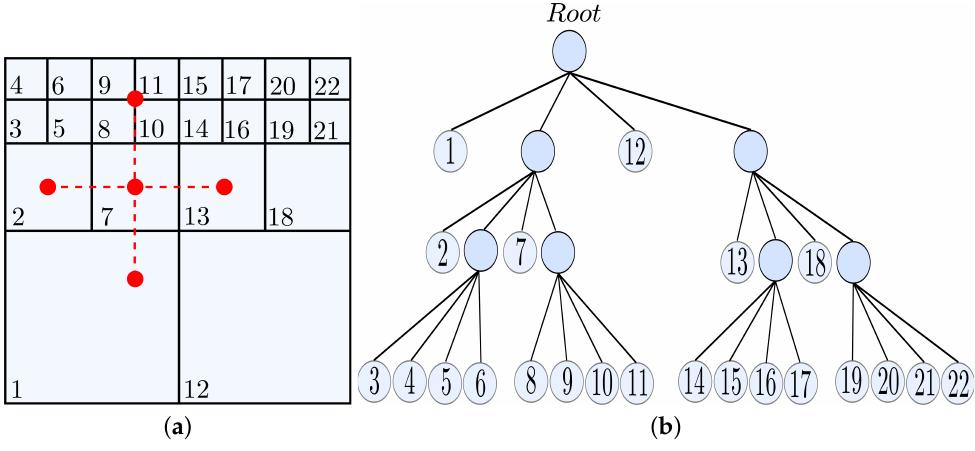
Figure 2. ( a ) Mesh refinement and the need to use an adaptive least squares method; ( b ) dependency